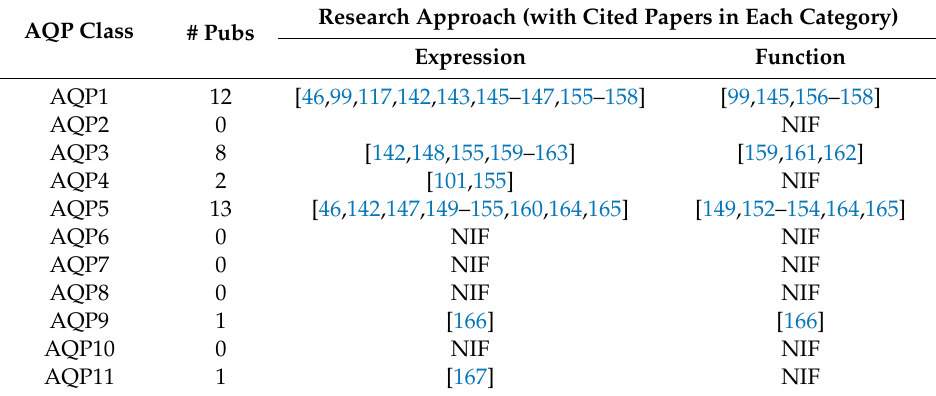
Table 4. Publications on AQPs in lung cancers, classified by research